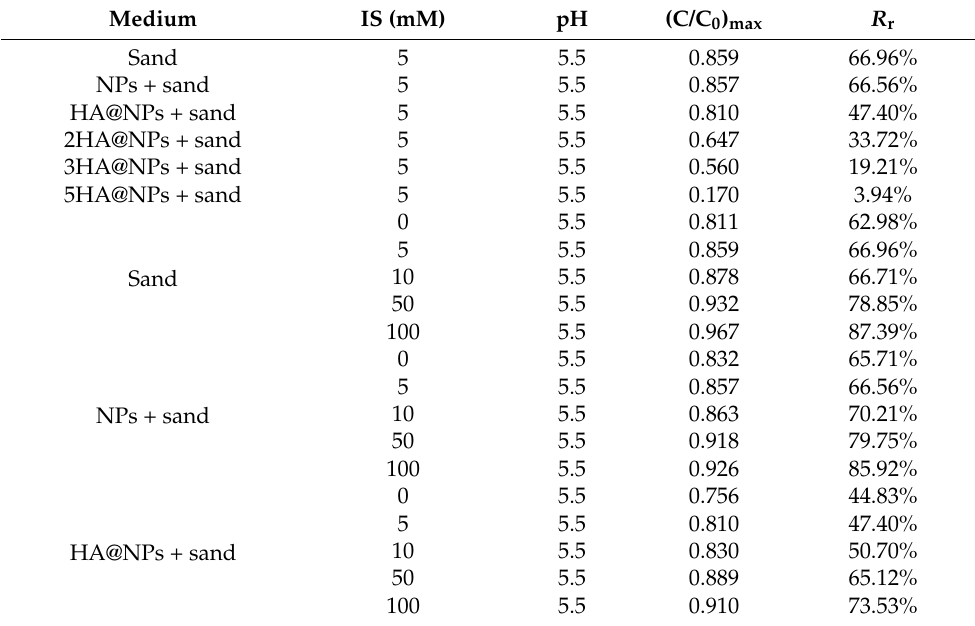
Figure 4. ( a ) Breakthrough curves of Cu 2+ in columns packed with different medium, sand, NPs + sand, 1HA@NPs + sand, 2HA@NPs + sand, 3HA@NPs + sand, and 5HA@NPs + sand; the IS was 5 mM and pH = 5.5; ( b ), ( c ) Breakthrough curves of Cu 2+ in columns packed with sand ( b ), NPs + sand ( c ), and 1HA@NPs + sand ( d ). The IS varied from 0 to 100 mM, while pH = 5.5. Table 1. Quantifying the breakthrough curves of Cu 2+ under different experimental